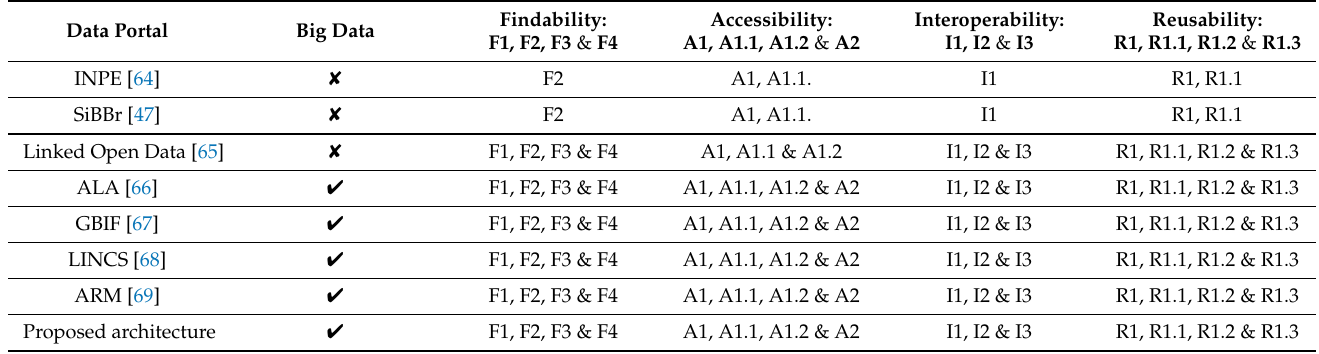
Table 1. Comparison of open data portals according to the FAIR